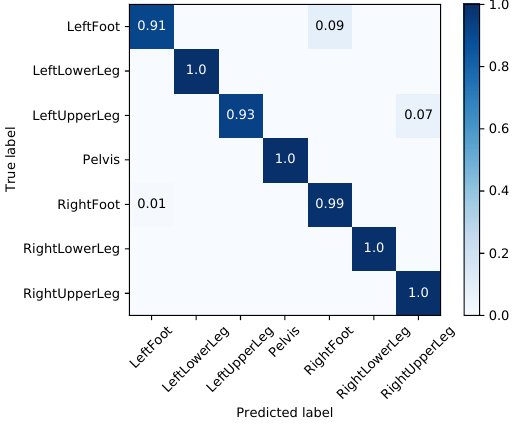
Figure A9. I2S assignment problem, final model: test person from dataset B , IMU configuration 8 (cf. Table A7). Average accuracy: 98.14%.